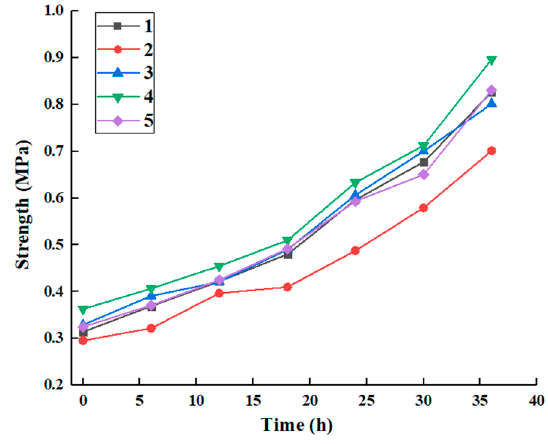
Figure 2. Early strength comparison curve.